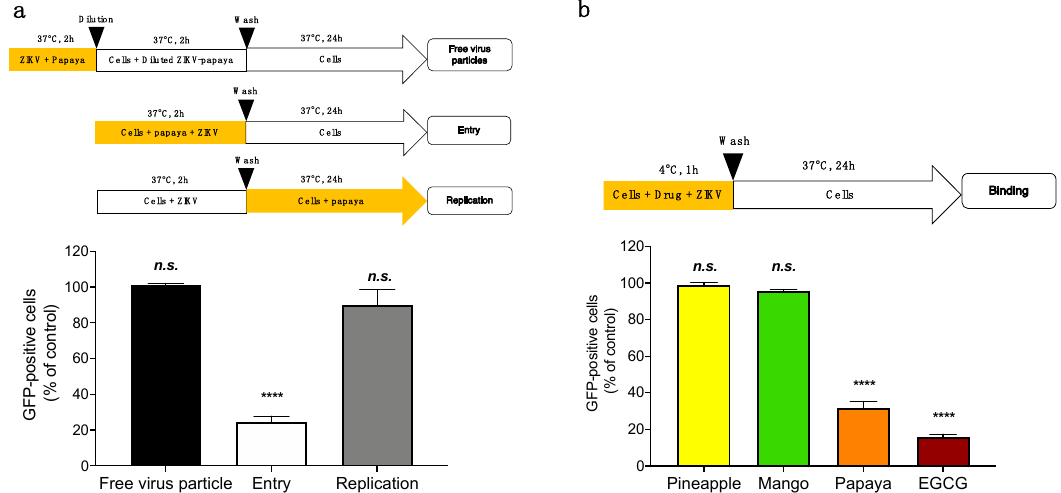
Figure 2. Papaya pulp extract inhibits ZIKV binding to the cell surface. ( a ) Schematic representation of time-of-drug-addition assay used to characterize antiviral activity of papaya pulp extract (1000 µg/mL) on ZIKV GFP infection of A549 cells. Orange arrows indicate the presence of pulp extract during the infection. Flow cytometric analysis of GFP expression in A549 cells infected with ZIKV GFP at MOI of 2 PFU/cell under the experimental conditions shown in the top. ( b ) A549 cells were infected with ZIKV at MOI of 2 PFU/cell for 1 h at 4 °C with or without 1000 µg/mL of papaya pulp extract. Pineapple juice and mango pulp extracts (1000 µg/mL) have been used as negative controls. EGCG (100 µM) was used as a positive control. After 24 h of infection, results of GFP-expression in ZIKV GFP -infected A549 cells under the experimental conditions, shown in the top, were analyzed by flow cytometry assay. The data represent the means ± SD of four independent experiments and are expressed as relative values compared to the mock-treated control. Statistical analyses were performed using a one-way ANOVA and Dunnett’s test for multiple comparisons (**** p < 0.0001; n.s. = not significant).